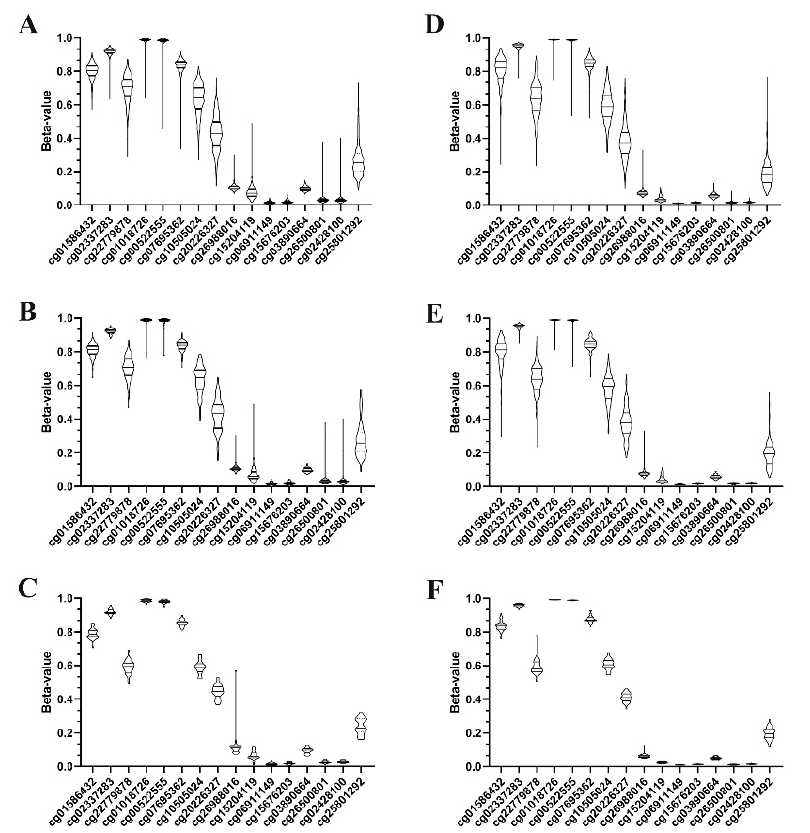
Figure 2. KEAP1 per-CpG violin plots of beta-values of the all-stages ( A : LUAD, D : LUSC), non-metastatic disease ( B : LUAD, E : LUSC) and control cohorts ( C : LUAD, F : LUSC). Violins report the median beta-values and interquartile ranges.